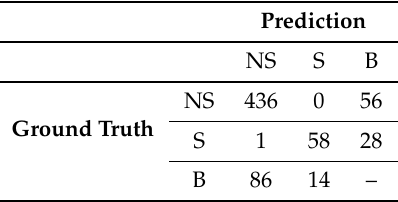
Table 10. Object Detection Confusion Matrix SegNet.